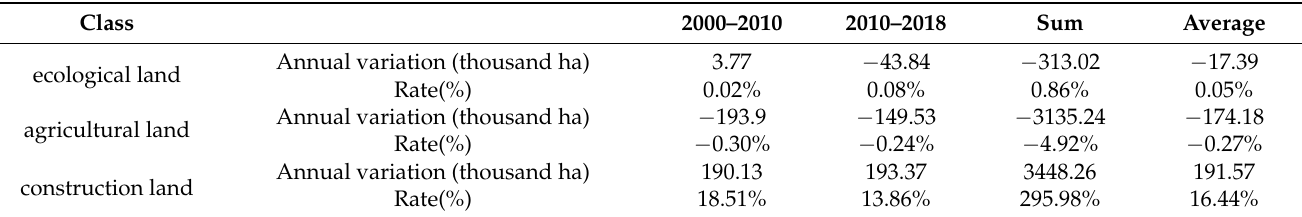
Table 6. Average annual change of land use area in YREB during the study